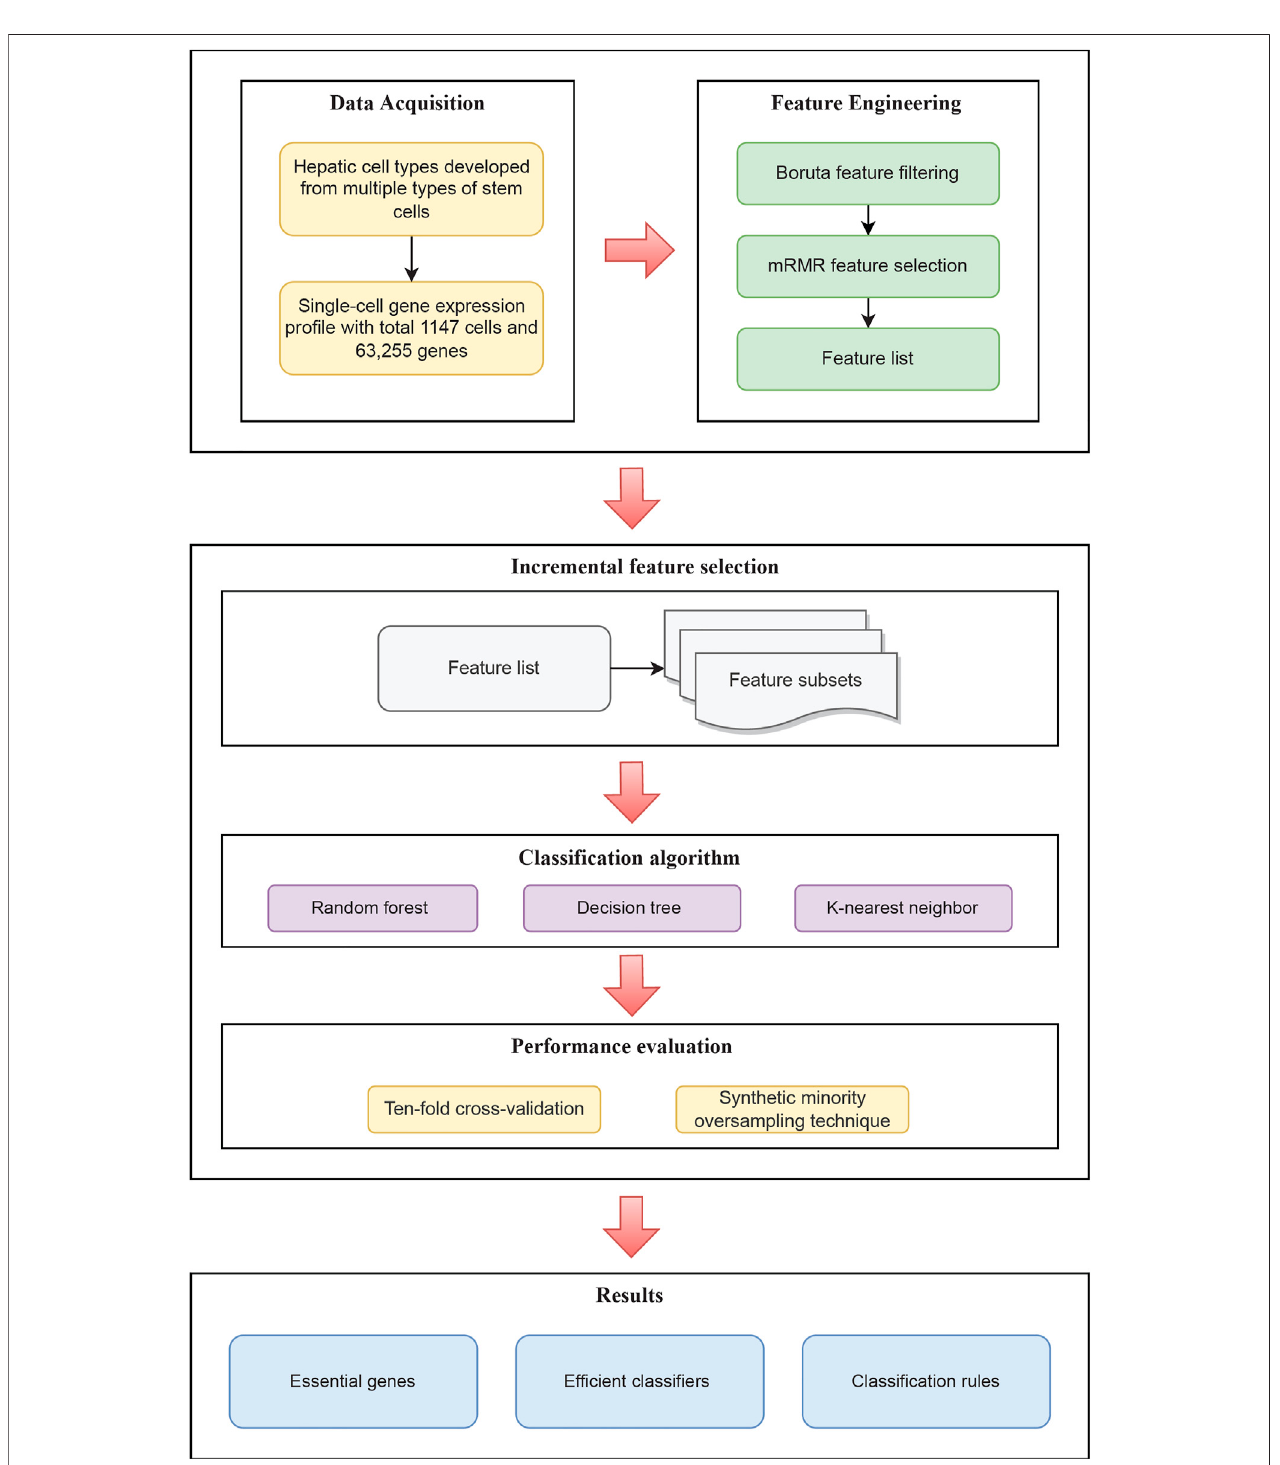
FIGURE 1 | Flow chart of the entire analysis process of this study. Single-cell RNA sequencing data acquired through the GEO database includes cells from 16 different hepatic cell types cultured in vitro . Following that, using feature selection methods, a sorted feature list is constructed. To recover ef fi cient genes, develop effective classi fi ers, and construct classi fi cation rules, this list is partitioned into feature subsets and put into the three classi fi cation algorithms.